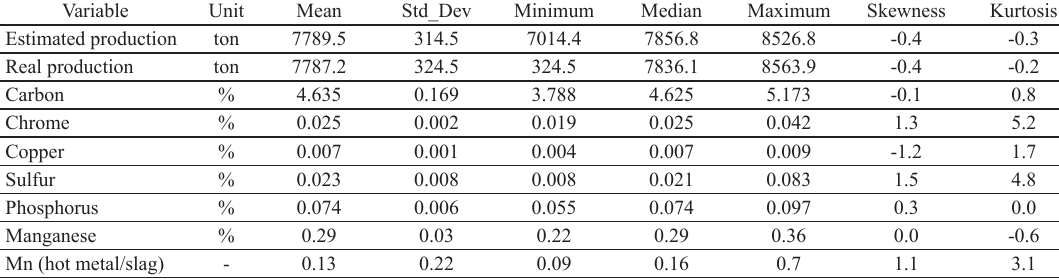
Table 11. Hot metal